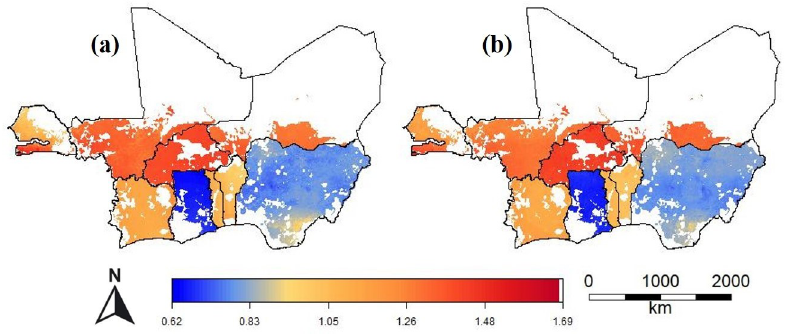
Fig 10. Urea price (USD kg -1 ) for crop land in West Africa predicted with (a) country level models and (b) with a single regional ensemble model.